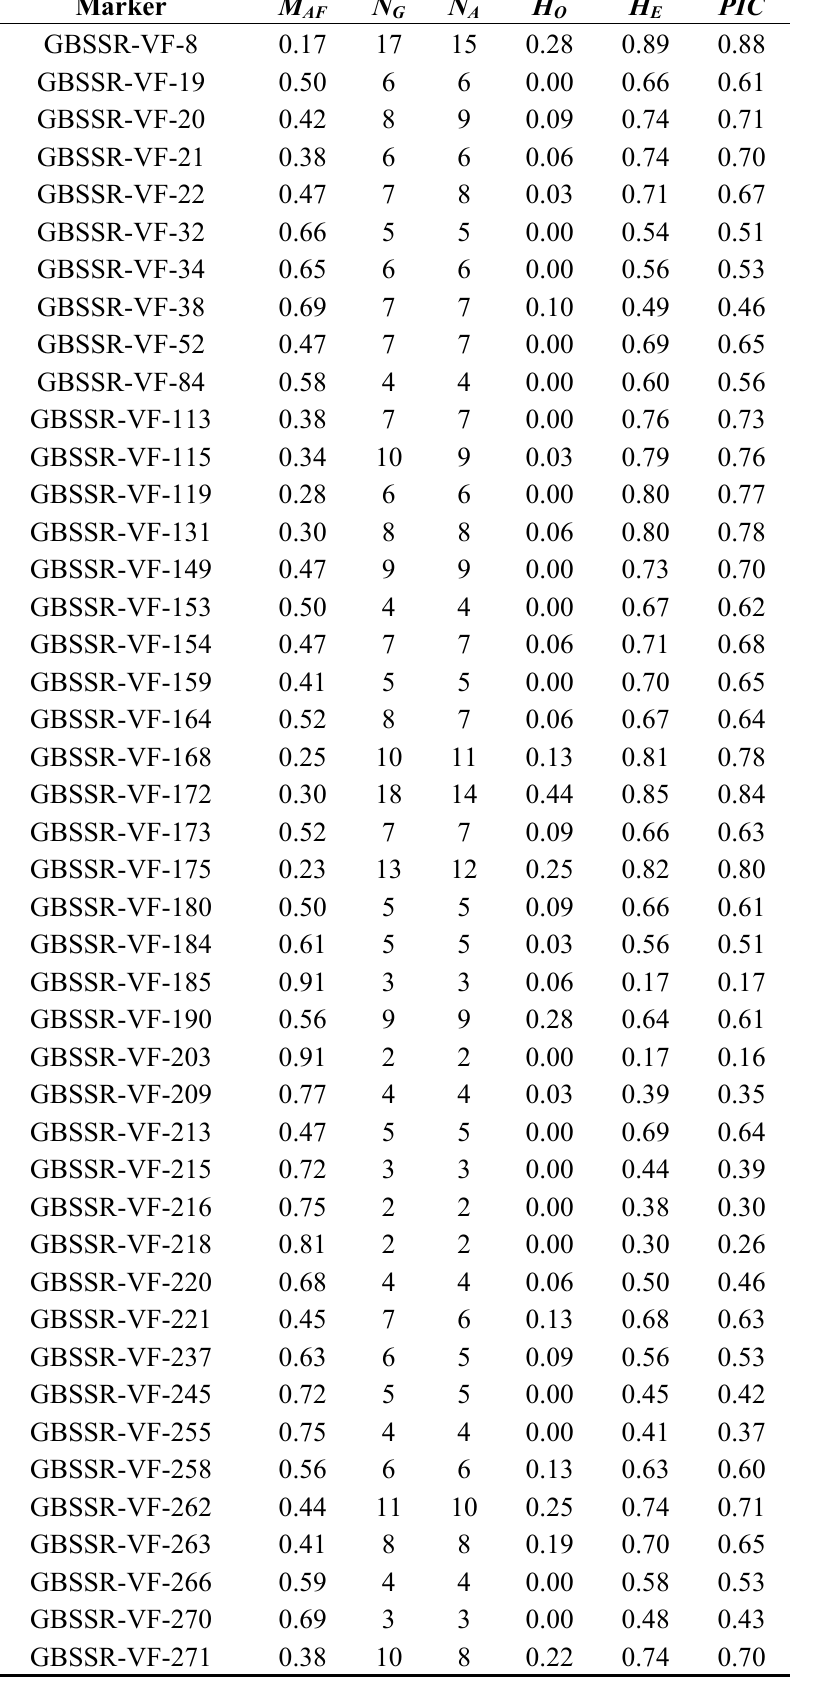
Table 2. Diversity statistics from initial primer screening in 32 accessions of faba bean ( Vicia faba L.)